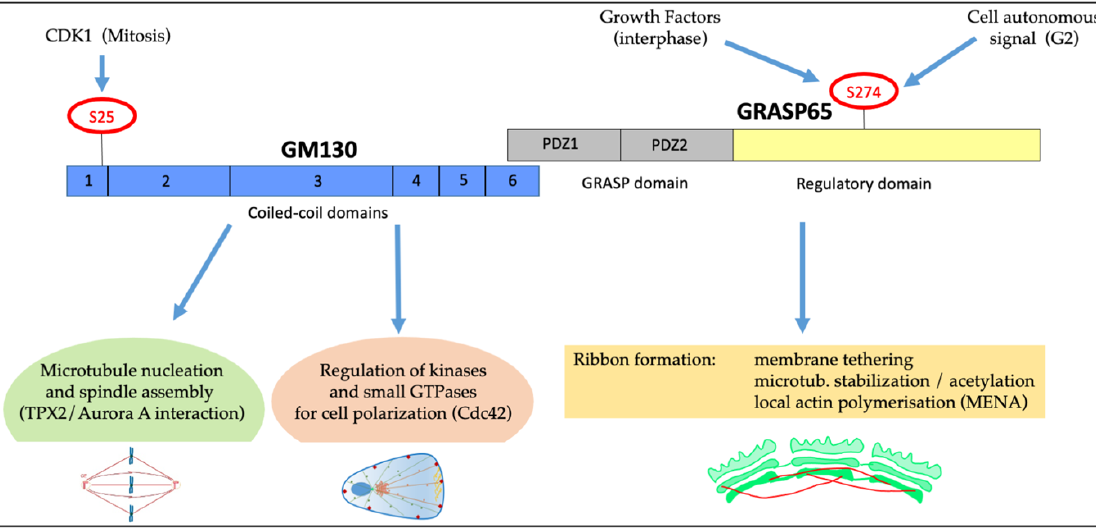
Figure 4. Schematic representation of GRASP65/GM130 complex and its role in polarization and mitosis. GM130 and GRASP65 form a complex at the GC and are involved in cell polarization and cell cycle progression. GM130, composed of six coiled-coil domains, is crucial for microtubules nucleation and spindle assembly and is involved in cell polarization. GRASP65, characterized by two PDZ domains (GRASP domain) and a regulatory domain, controls ribbon organization by multiple mechanisms: tethering of the Golgi stacks, control of microtubules stabilization and local actin polymerization via MENA. The S274 of the regulatory domain is phosphorylated in response to many stimuli, as indicated.